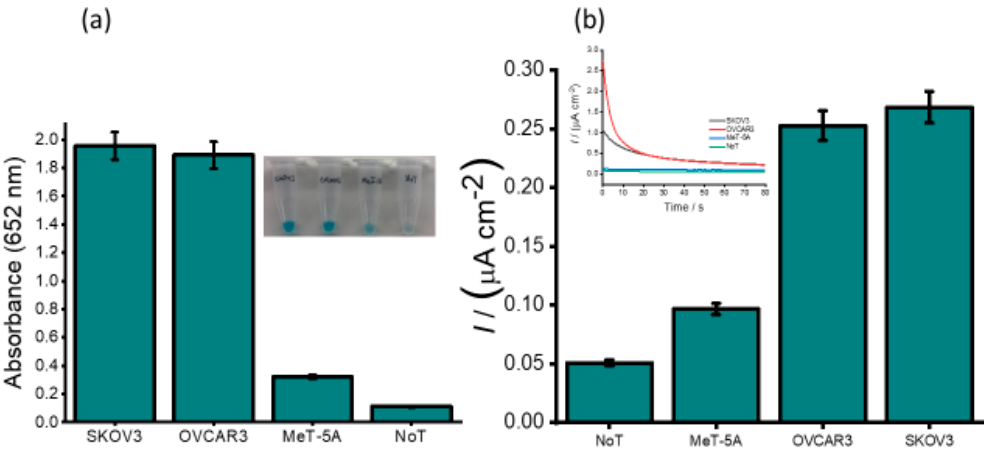
Figure 7. Analysis of ovarian cancer and normal cell lines. ( a ) Absorbance (UV–vis) obtained for SKOV3, OVCAR3 (ovarian cancer) and MeT-5A (non-cancerous) cell lines, no-template (NoT) controls (inset: picture of the naked-eye detection). ( b ) Amperometric responses for HOTAIR sequences in cell lines. Error bars represent the standard deviation of three repeated experiments.